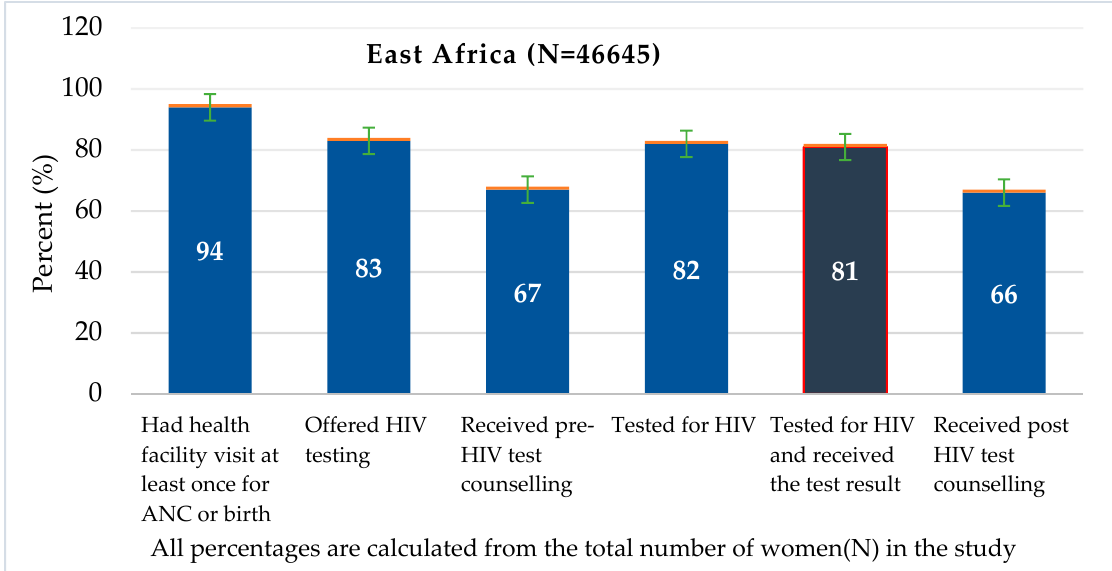
Figure 1. Women who used prenatal HIV testing services for prevention of mother to child transmission of HIV in East African countries (2011–2017).